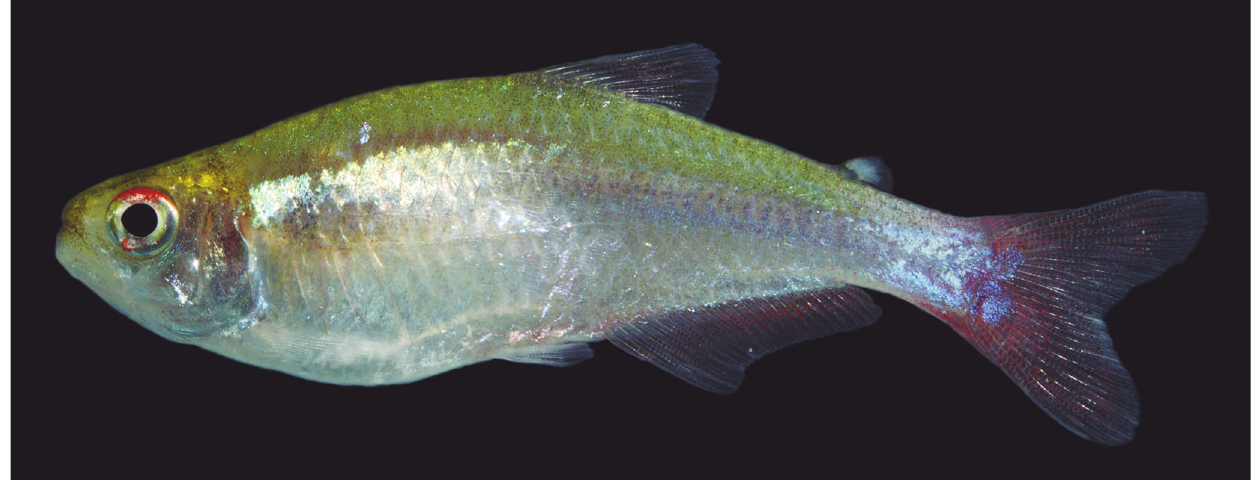
Fig. 3. Boehlkea weitzmani , unsexed, live specimen, rio Japurá basin, Amazonas State, Brazil (specimen not cataloged). Photo: D.